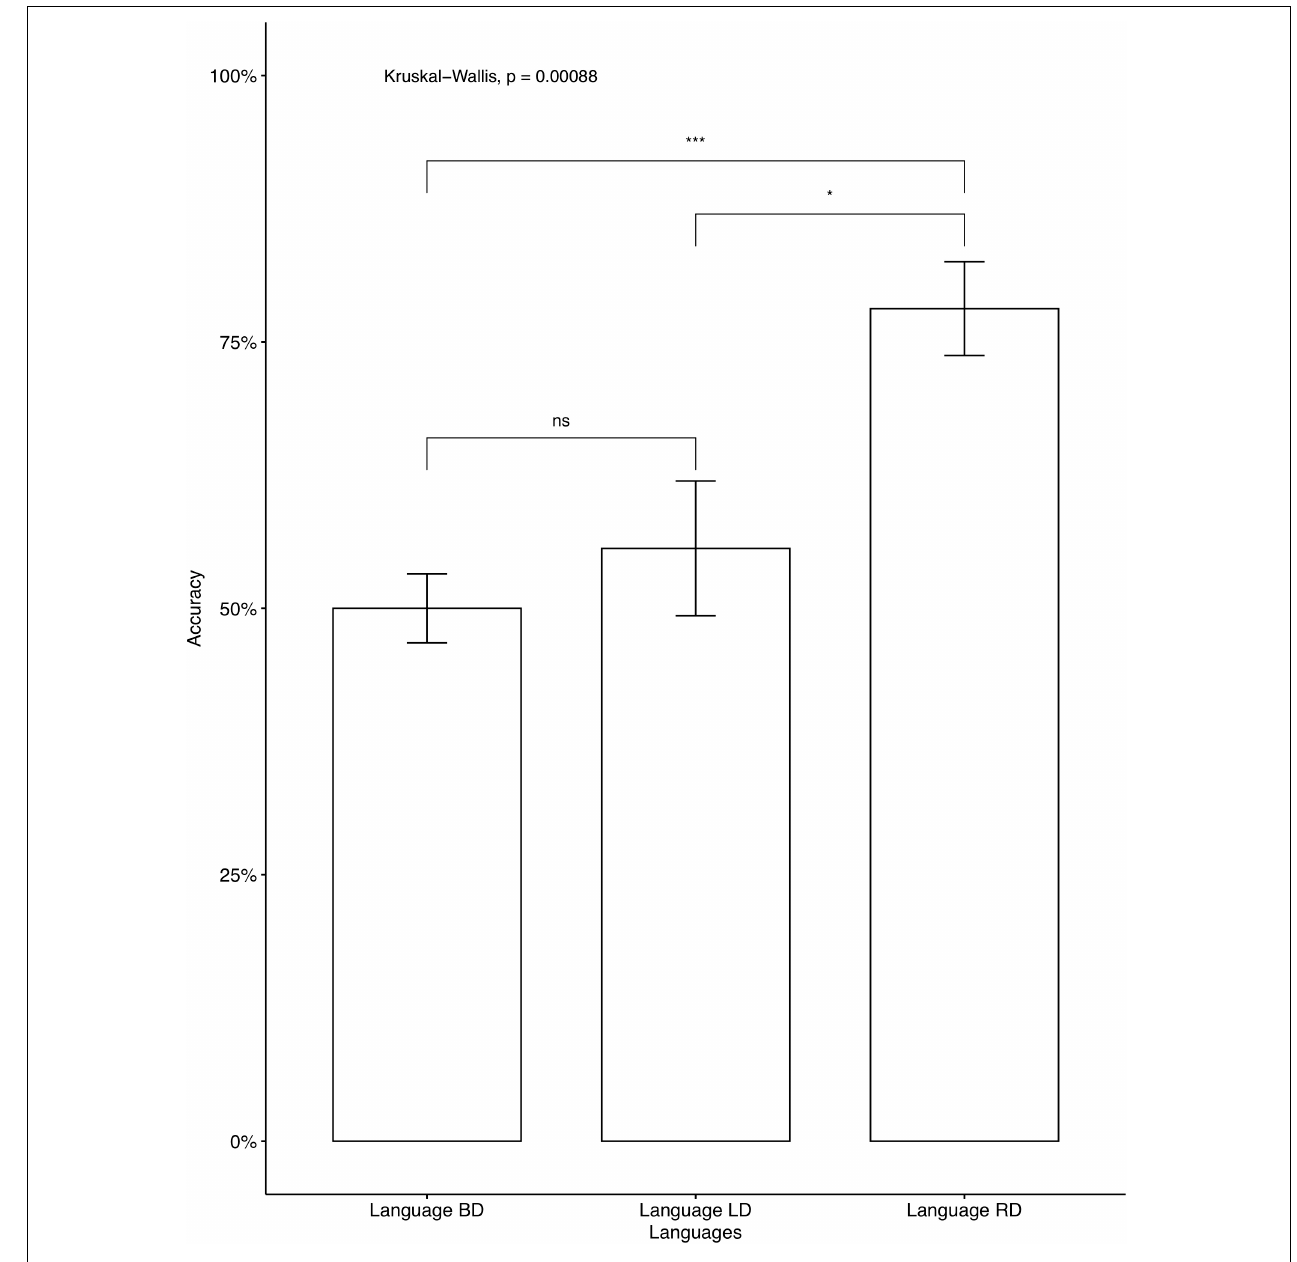
FIGURE 2 | Accuracy on critical seen items: Mandarin native speakers. The 95% confidence interval is specified for each bar. *indicates significant mean difference, p < 0.05. ***indicates significant mean difference, p < 0.001.